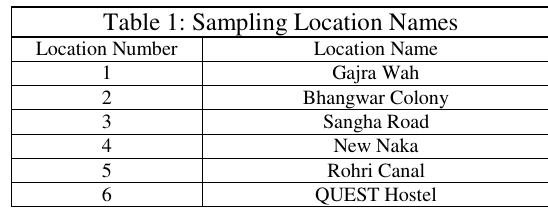
Table 2: Water Type from Sampling Locations